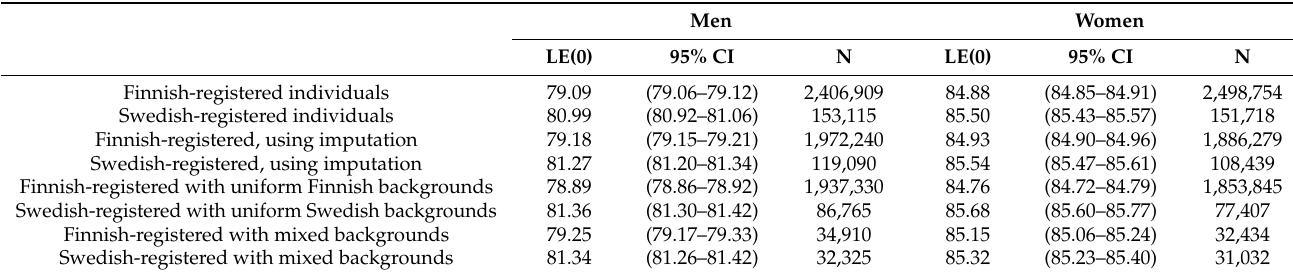
Table 1. Life expectancy at birth in Finland in 2015 by individuals’ own and parental ethnolinguistic affiliation for men and